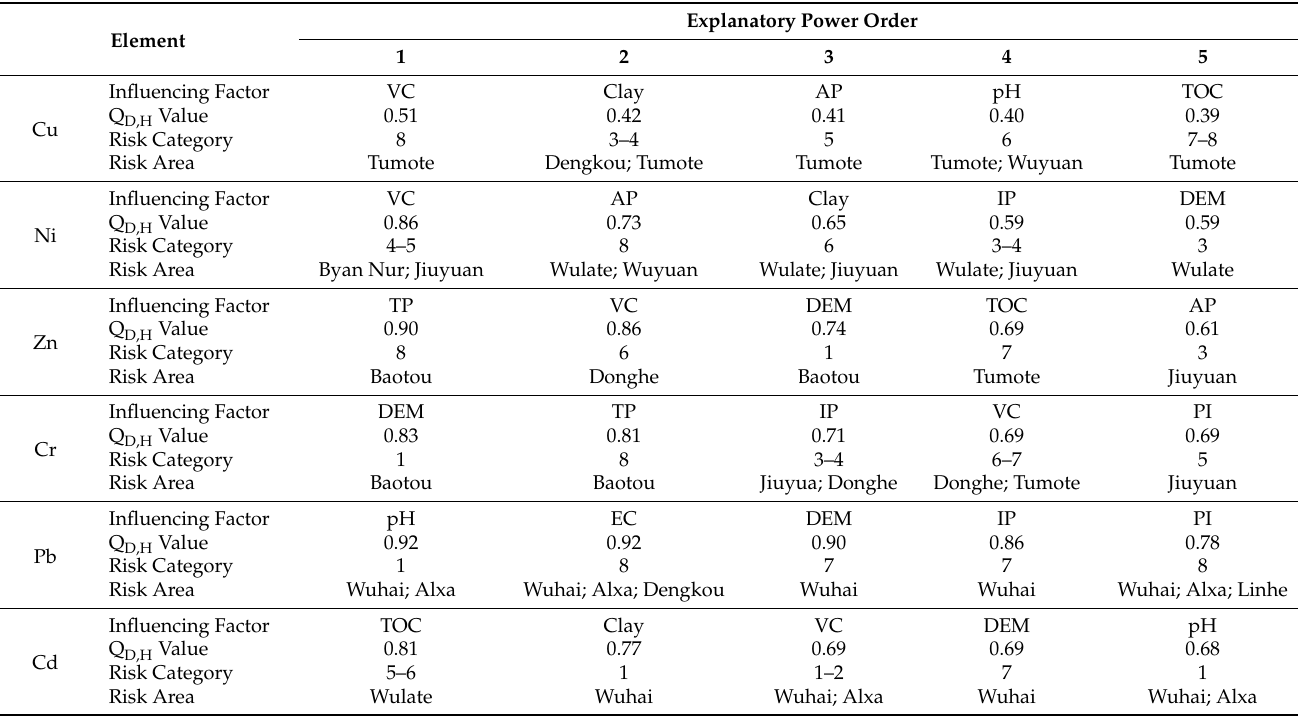
Table 2. Influencing factors and risk detection results of heavy metals in the sediment of the Inner Mongolia section of the Yellow